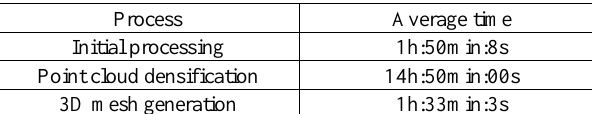
Table 7. Processing times, UAV images from Jun 20, 18 Process Average time Initial processing